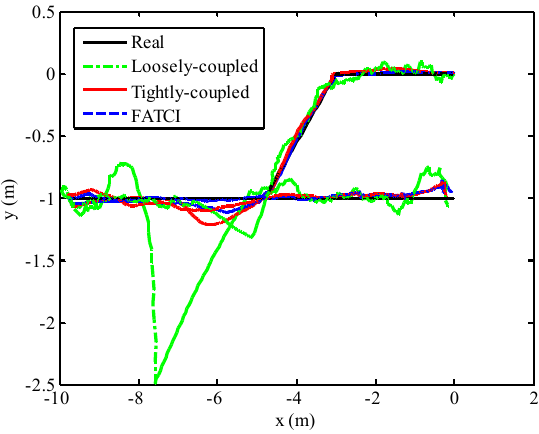
Figure 14. Positioning performance with different integrated methods based on WSN short-term failure.